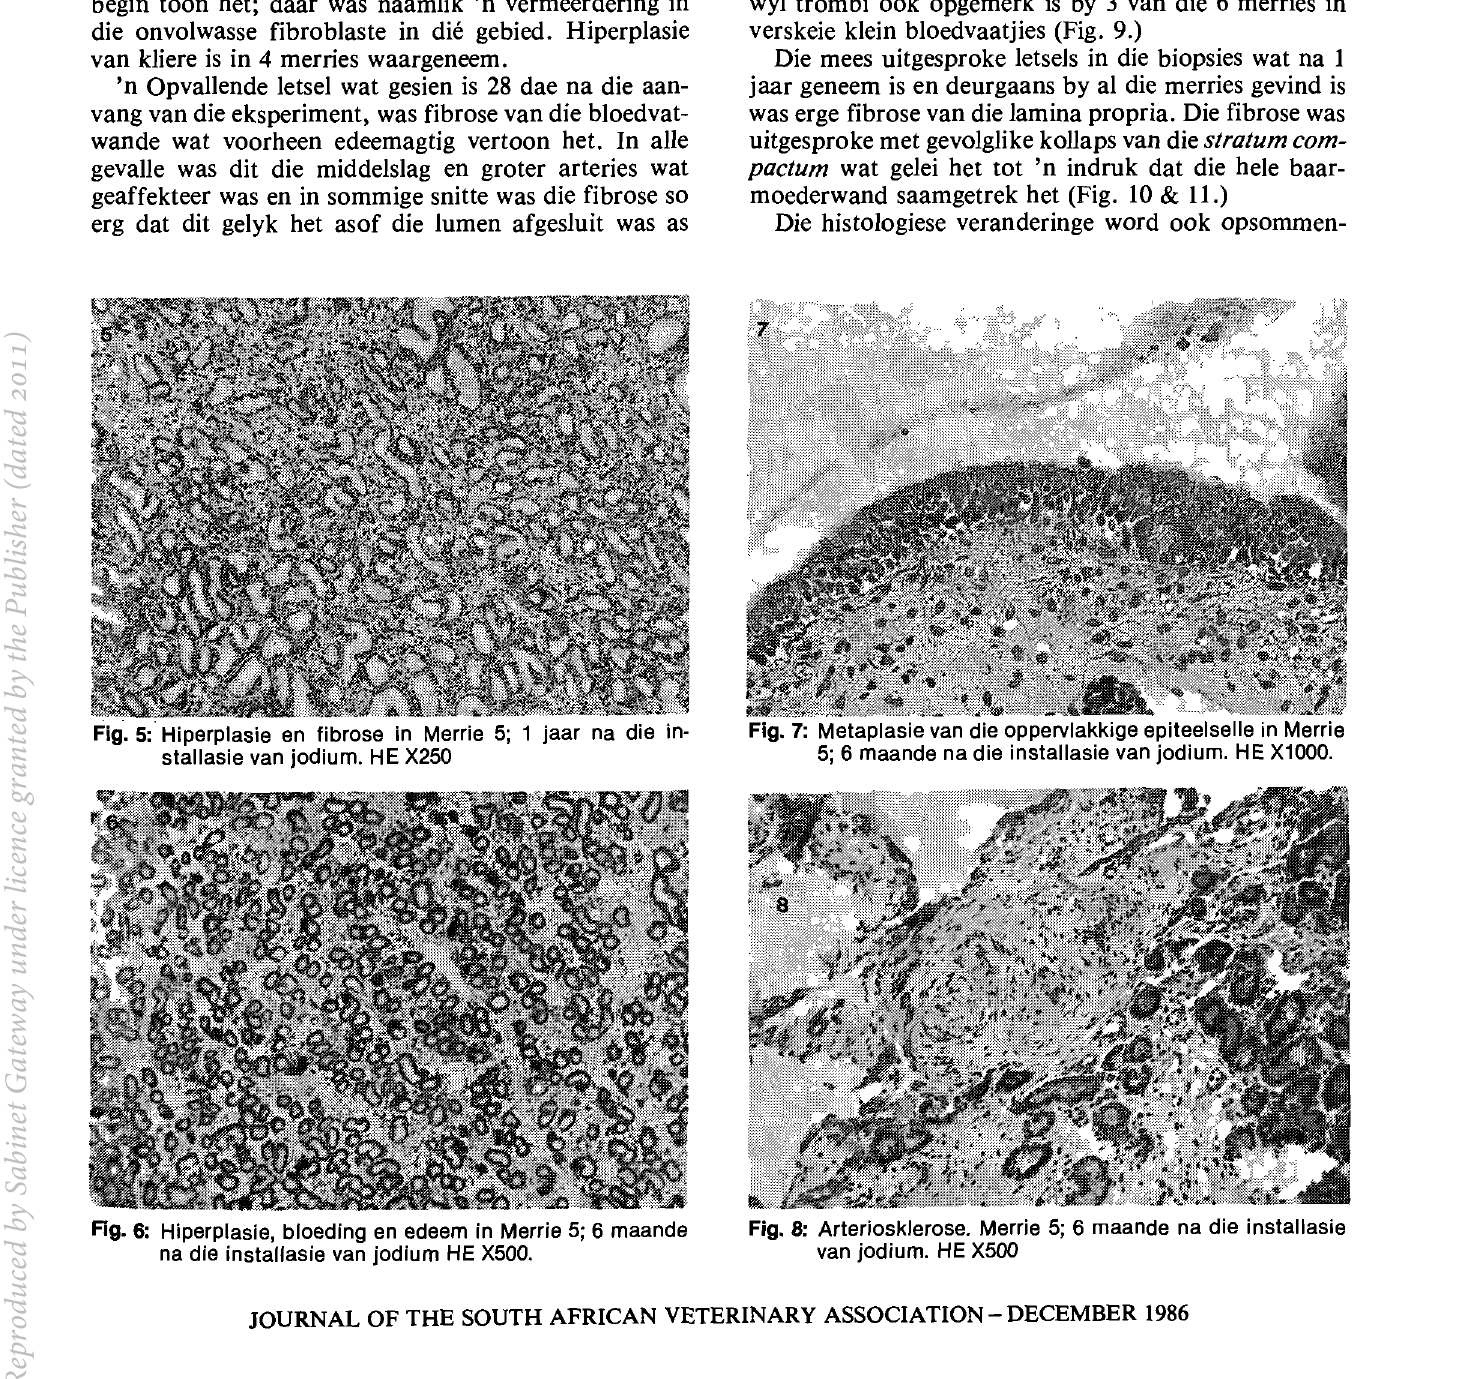
Fig. 6: Hiperplasie, bloeding en edeem in Merrie 5; 6 maande na die instal/asie van jodium HE X500.